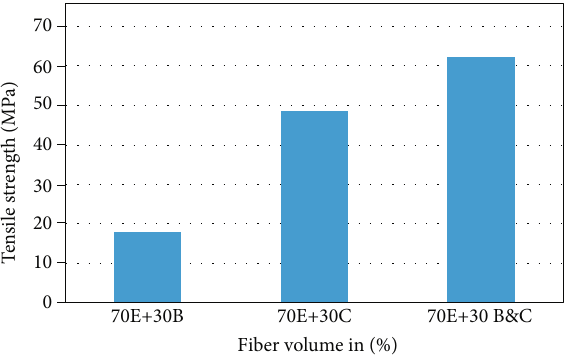
Figure 6: Tensile strength with di ff erent fi ber contents.